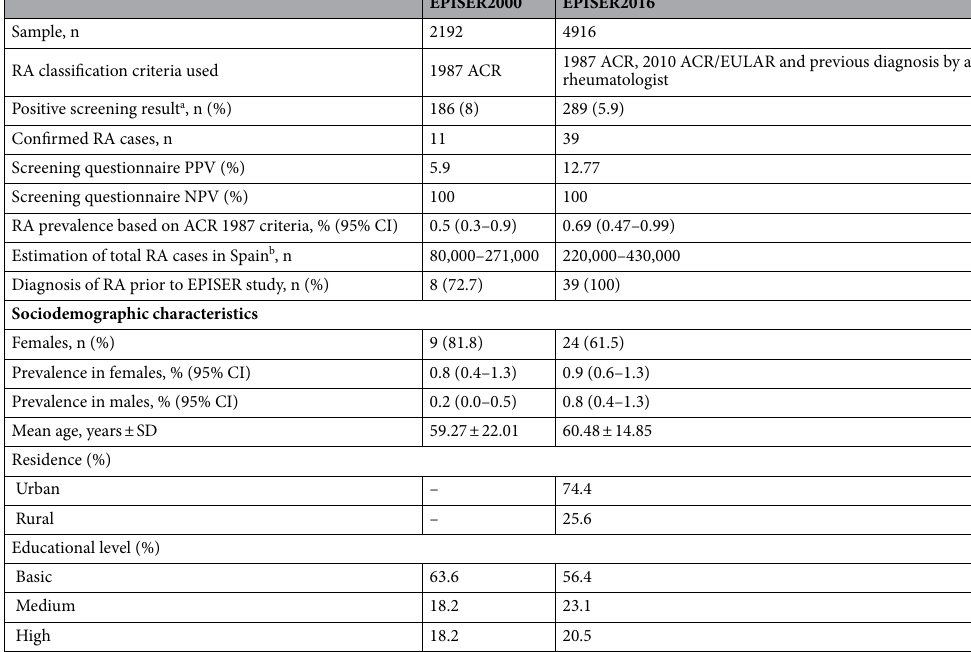
Table 3. Comparison between EPISER2000 and EPISER2016 studies. RA rheumatoid arthritis, SD standard deviation, CI confidence interval, PPV positive predictive value, NPV negative predictive value. a Screening questionnaire: EPISER2000 used a questionnaire administered by a rheumatologist in a face-to-face interview, while EPISER2016 used a phone questionnaire administered by the call centre interviewers. b These estimates were calculated considering the lower and upper limits of the confidence intervals of the prevalence and the figures of the population aged 20 years old or over in Spain in the years 2000 and 2016. The confidence interval used for EPISER2016 was that corresponding to the prevalence of